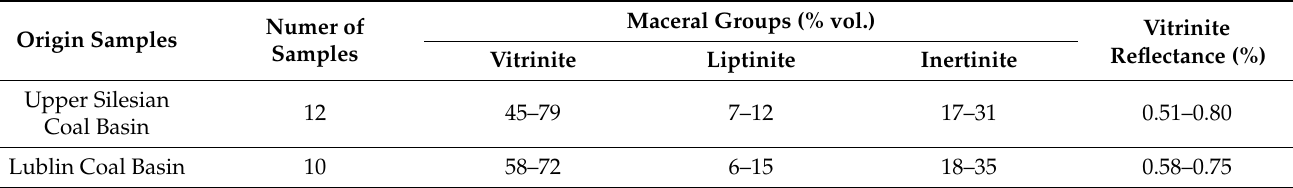
Table 1. Data on the tested coal